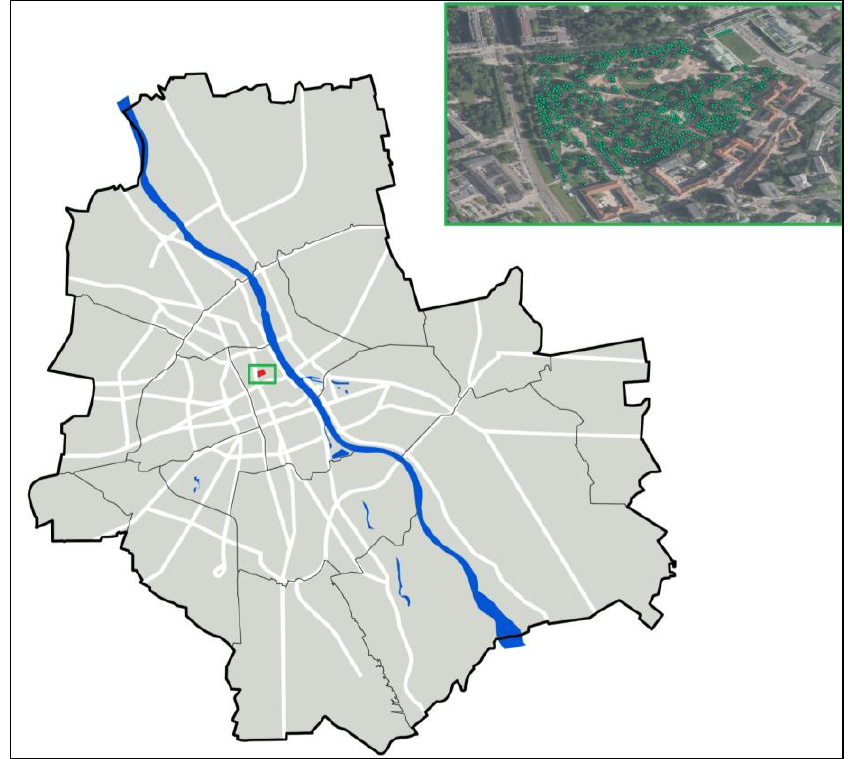
Fig. 1. The surveyed area - Krasiński Gardens (Warsaw, Poland) (source: author’s own